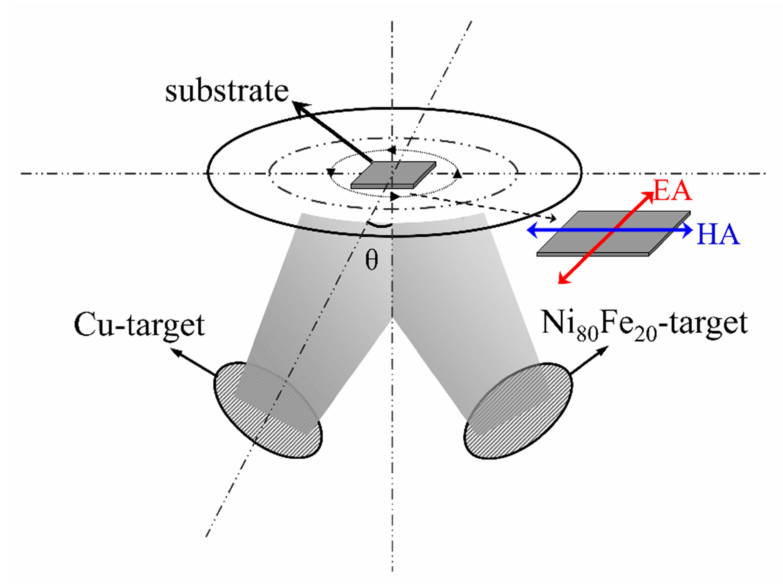
Figure 1. The schematic diagram of obliquely